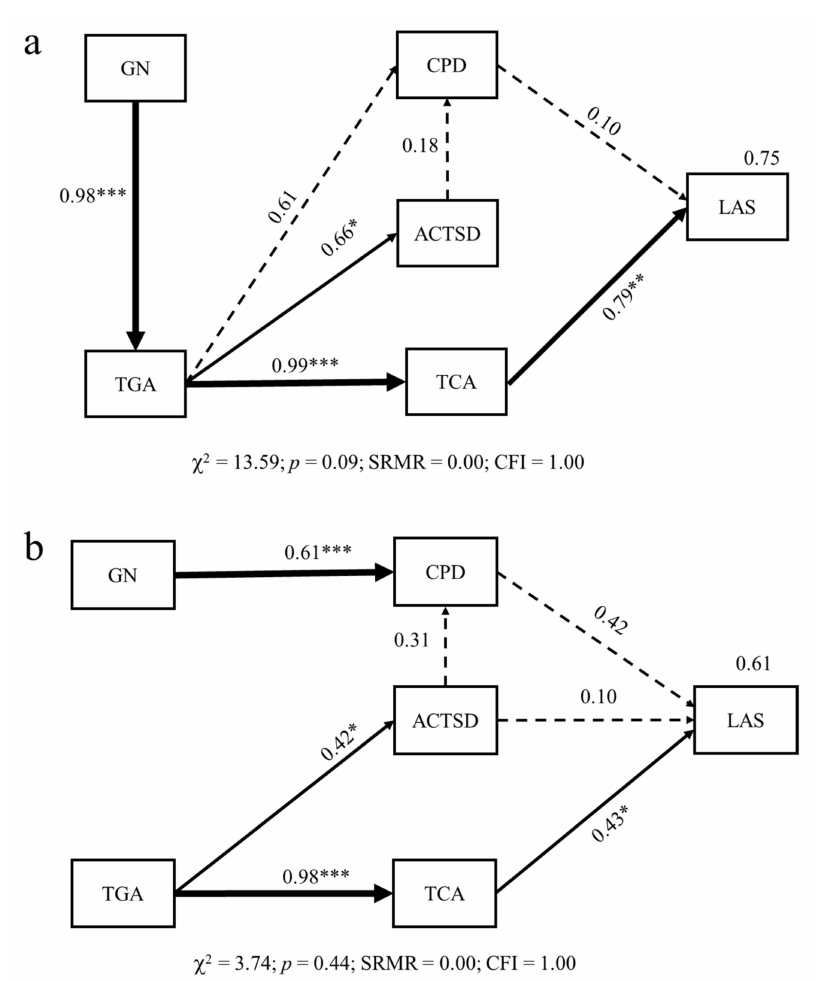
Figure 7. Path models for the effects of canopy gaps on ACTSD, CPD, TCA, and LAS ( a ) at medium canopy group level and ( b ) at the plot level. ACTSD–autumn color-leaved tree species diversity; CPD–color-leaved patch diversity; GN–number of gaps; LAS–landscape aesthetic service; TCA–total color-leaved patch area; TGA–total gap area. Numbers at arrows are standardized path coefficients ( λ ); *, ** and *** indicate p < 0.05, p < 0.01, and p < 0.001, respectively. Solid black lines indicate significant pathways ( p < 0.05) and dashed black lines indicate nonsignificant pathways ( p > 0.05); the strength of pathways is indicated by the width of the lines. R 2 values labeled above the response variables indicate the proportion of variation explained by the relationship with other variables. The goodness-of-fit tests are shown at the bottom of each path